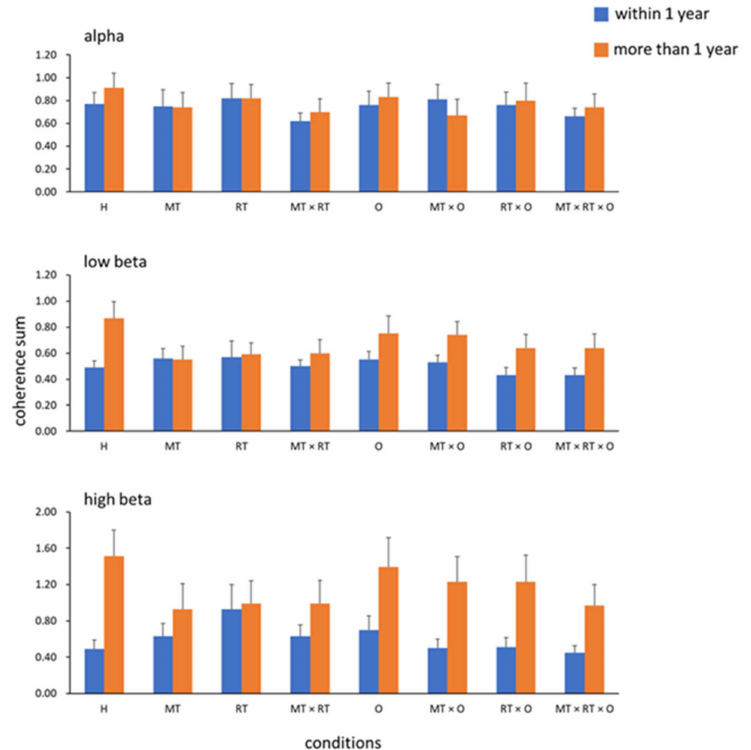
Figure 4. Interhemispheric coherences in the three bands: the alpha, low beta, and high beta bands. As the two groups had significant differences in stroke onset times, they were sepa- rately analyzed in the following analyses. In each analysis of the onset ≤1 year group and onset >1 year group, we first examined the interaction effect of the damaged brain area (cortical vs. subcortical) and affected hand side (right hemisphere vs. left-hemispheric), respectively. If the interaction effect was significant, an additional subgroup was used for further analysis. 2 = 0.3) (Tables 2 and 3). In